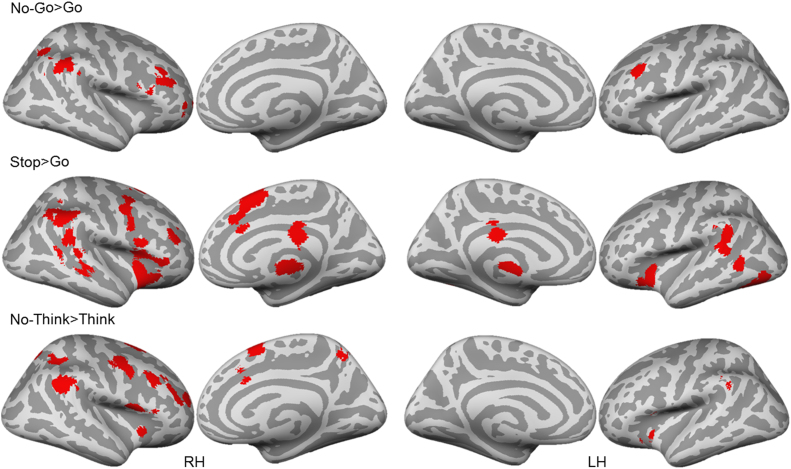
Cortical activations from the task-specific meta-analyses. All clusters are thresholded using cluster-level inference (p<.05, uncorrected p<.001, threshold permutations=1000).